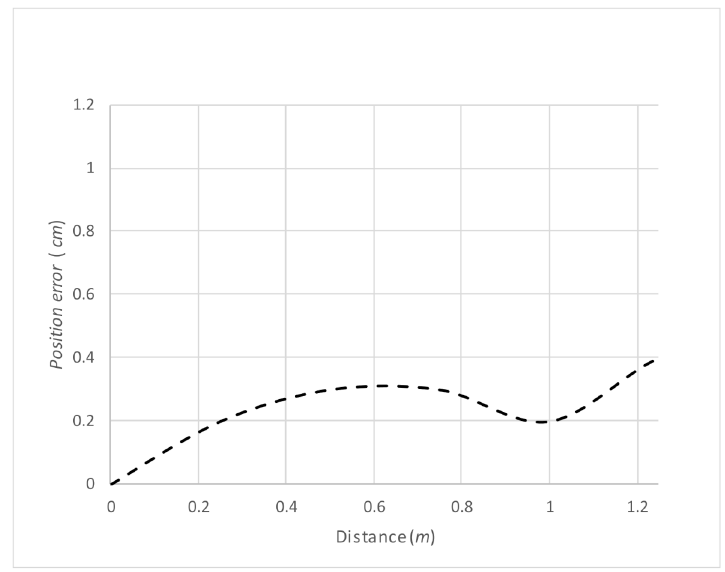
Figure 15. Errors in robot location during travel in the environment shown in Figure